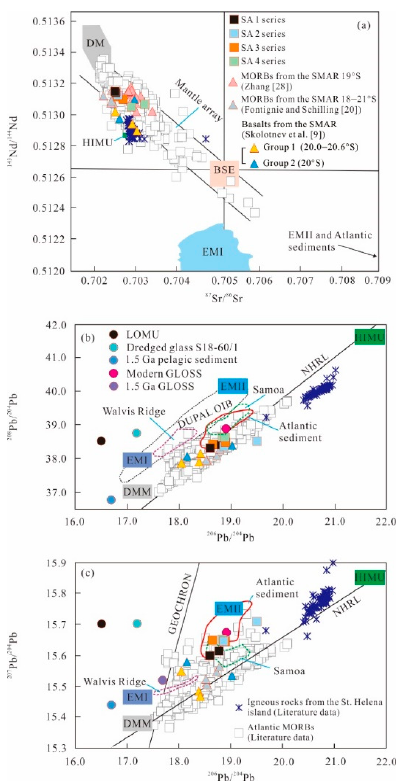
Figure 2. 87 Sr/ 86 Sr versus 143 Nd/ 144 Nd ( a ), 206 Pb/ 204 Pb versus 208 Pb/ 204 Pb ( b ), and 206 Pb/ 204 Pb